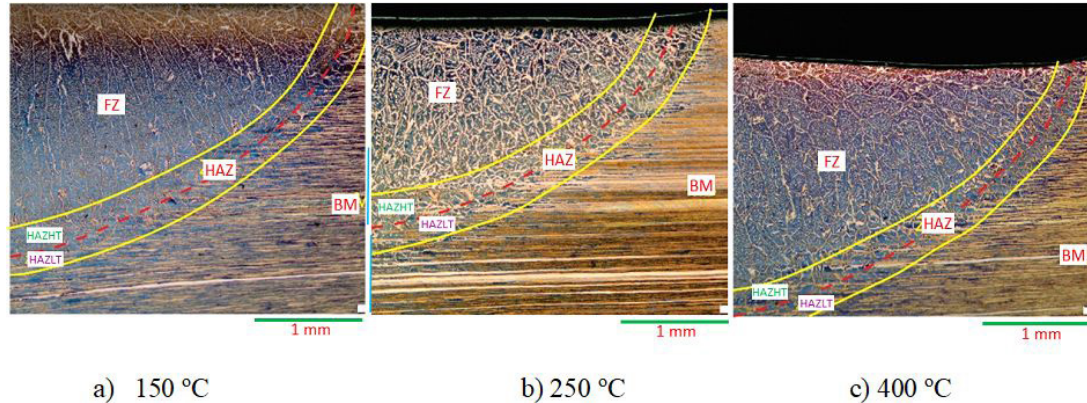
Figure 3. Transversal section of the weld region produced by TIG process with inter-passes temperatures: a) 150 °C, b) 250 °C, c) 400 °C, respectively. (Caption: BM – base metal; FZ- fusion zone; HAZ- heat affected zone, HAZHT- heat-affected zone of high temperature and HAZLT- heat-affected zone of low temperature).